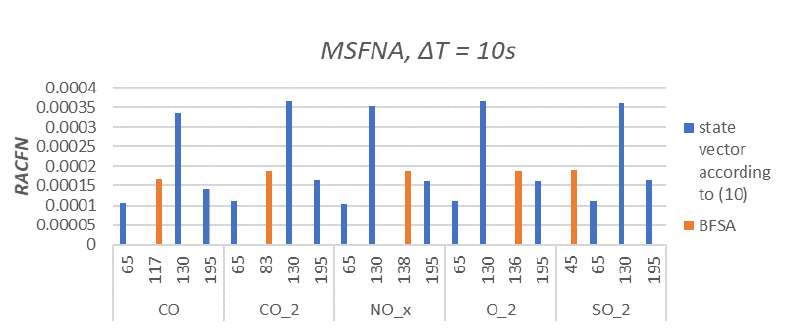
Figure 6. Relative Areal Cumulative False Neighbors for sampling periods ∆ T = 5 s. Orange columns are state vectors proposed by BFSA and blue columns are state vectors created according to (11) with n ui = n yj = [ 5, 10, 15 ] . Axis x represents the number of features n x for specified y i .